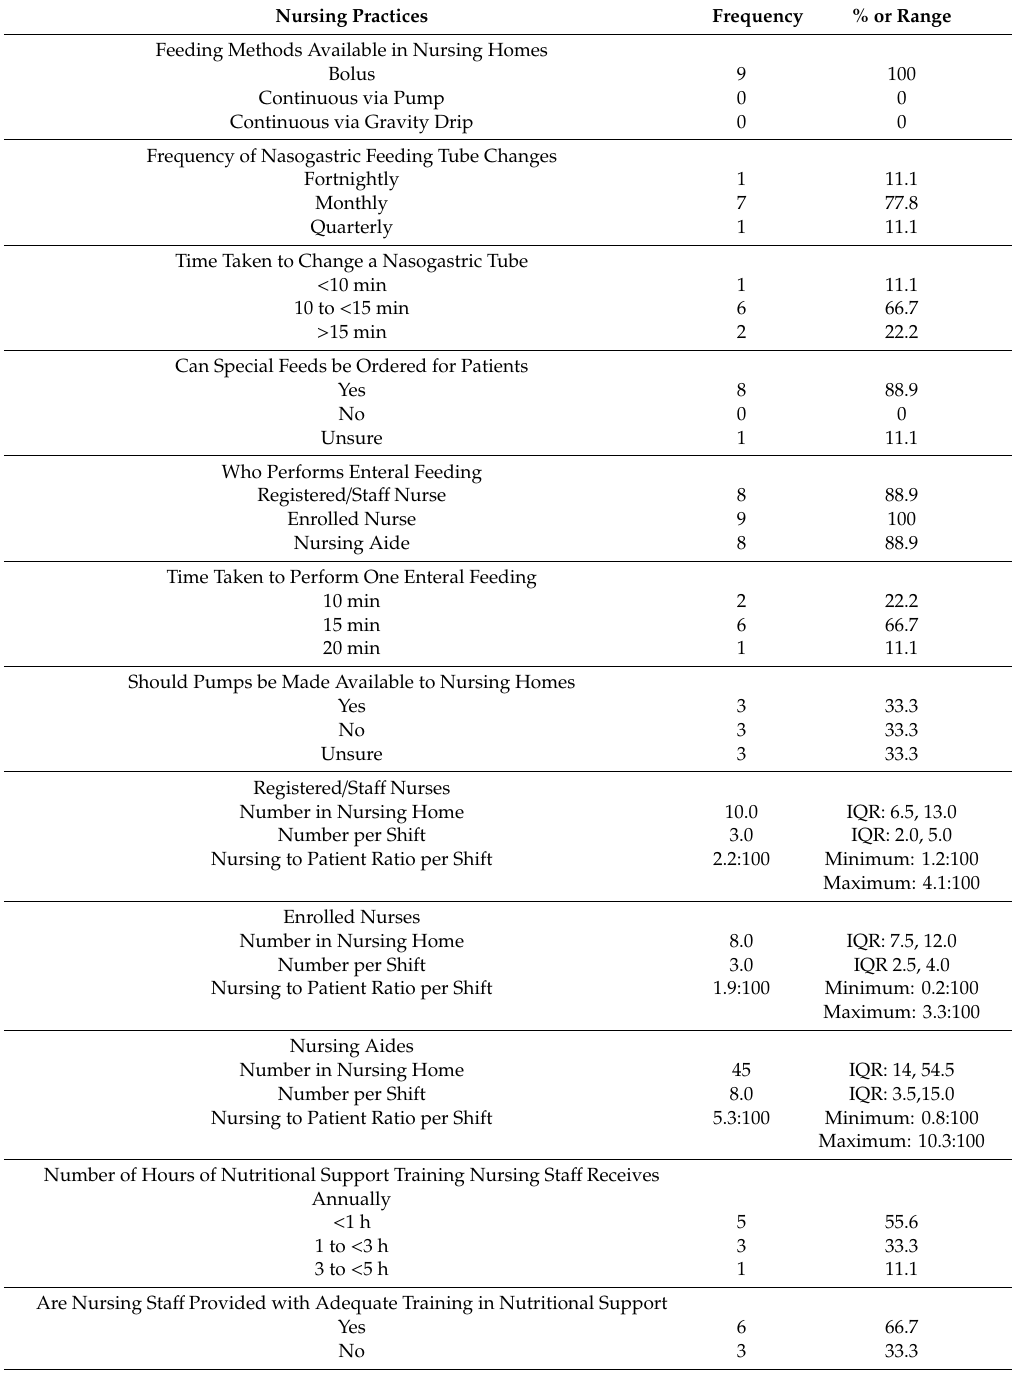
Table 2. Nursing Practices and Manpower in Nursing Homes. Nursing Practices